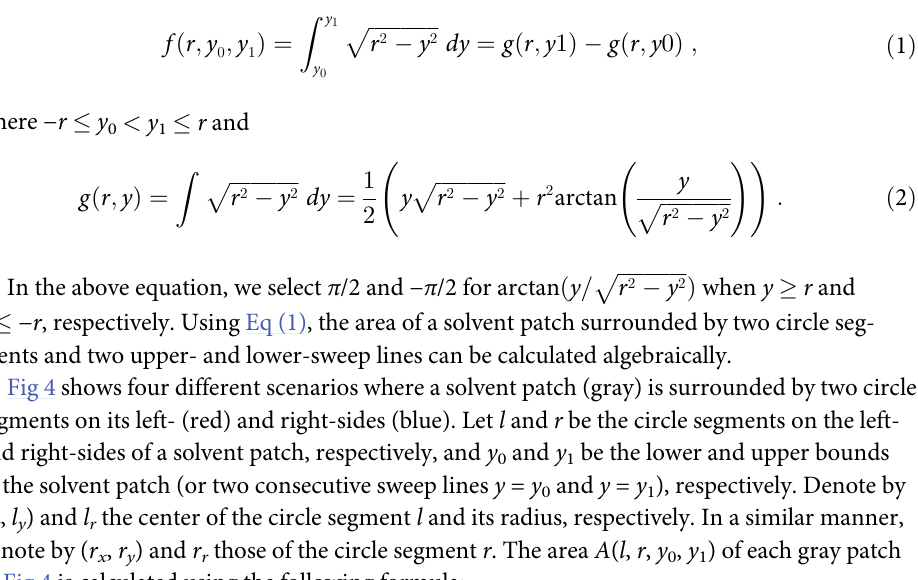
Algorithm 5 calculates the total area of solvent patches. The algorithm takes as input the set P of solvent patches and two event points e